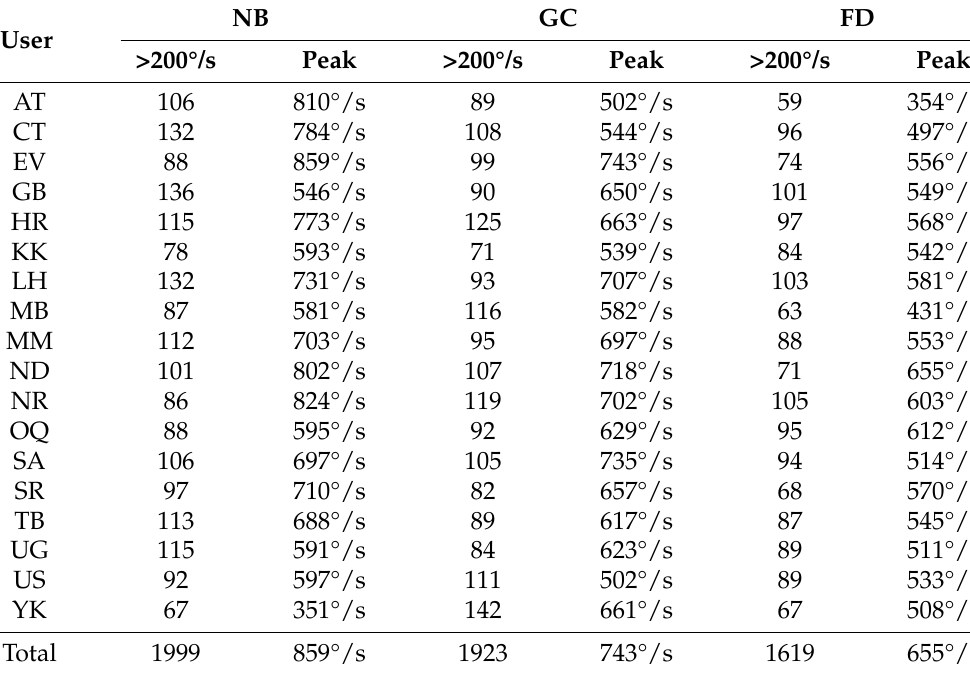
Table 4. Comparison of angular speed during saccadic motion for each user. Number of occurrences of speeds greater than 200°/s and the peak speed observed are shown. (conditions: NB—No Blur; GC—Unity Blur;